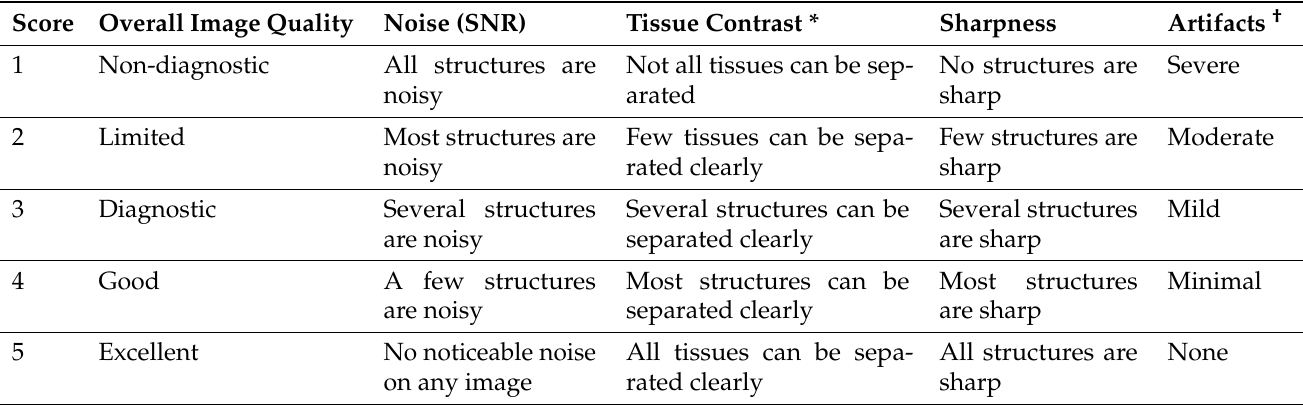
Table 1. Absolute image scores (1: worst, 5: best).